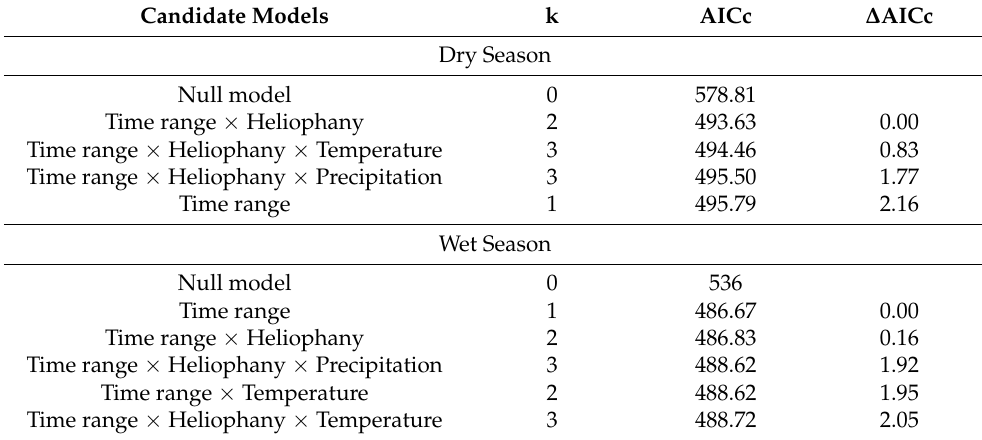
Table 1. Best candidate models explaining the number of individuals according to the AIC criteria for the dry and wet season separately. Only candidate models ( ∆ AIC < 2) are shown. k = number of parameters.